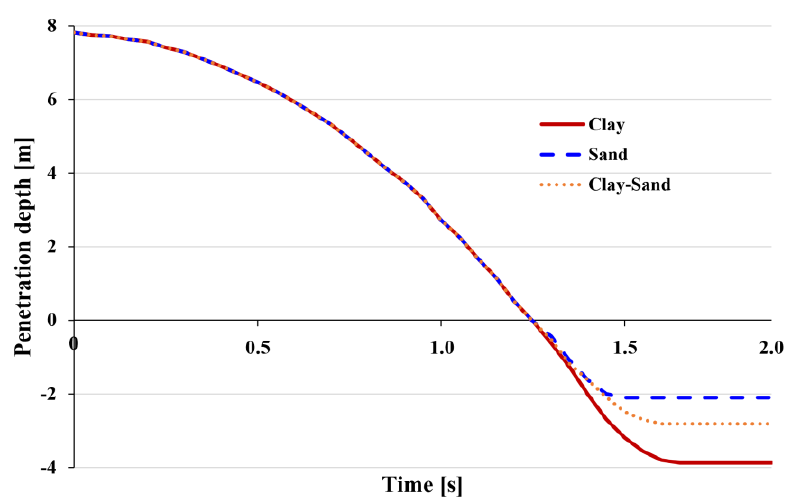
Figure 10. Comparison for penetration depth of anchor pile.